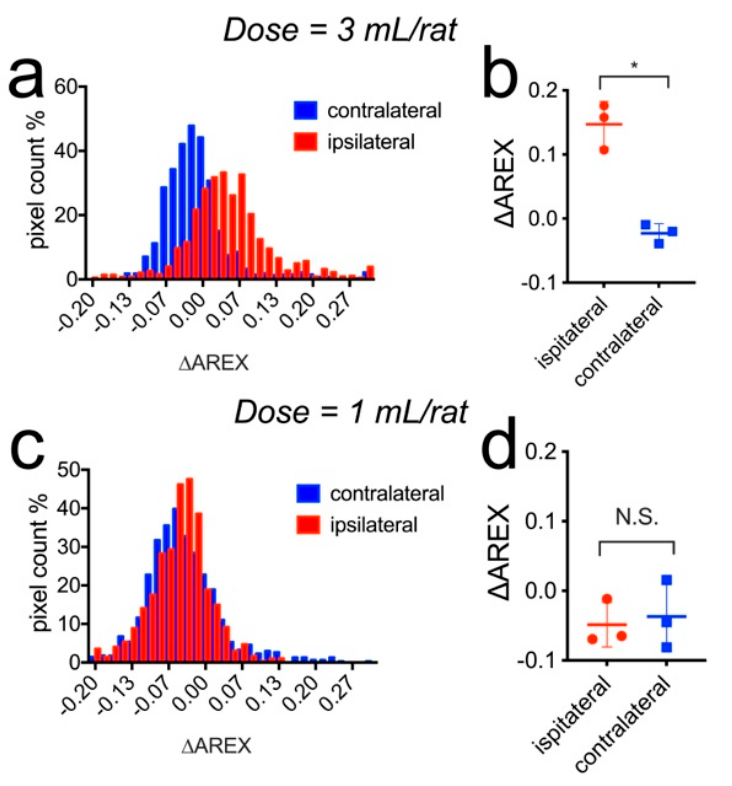
Figure 9. Comparison of the change in CEST contrast ( ∆ AREX) in the ipsilateral and contralateral hemispheres after the injection of mannitol at different doses. ( a ) Histogram and ( b ) Mean values of three rats injected with 3 mL 25% mannitol. *: p = 0.0237, paired two-tailed Student t -test, n = 3. ( c ) Histogram and ( d ) Mean values of three rats injected with 1 mL 25% mannitol. N.S.: p = 0.4297, paired two-tailed Student t -test, n = 3.